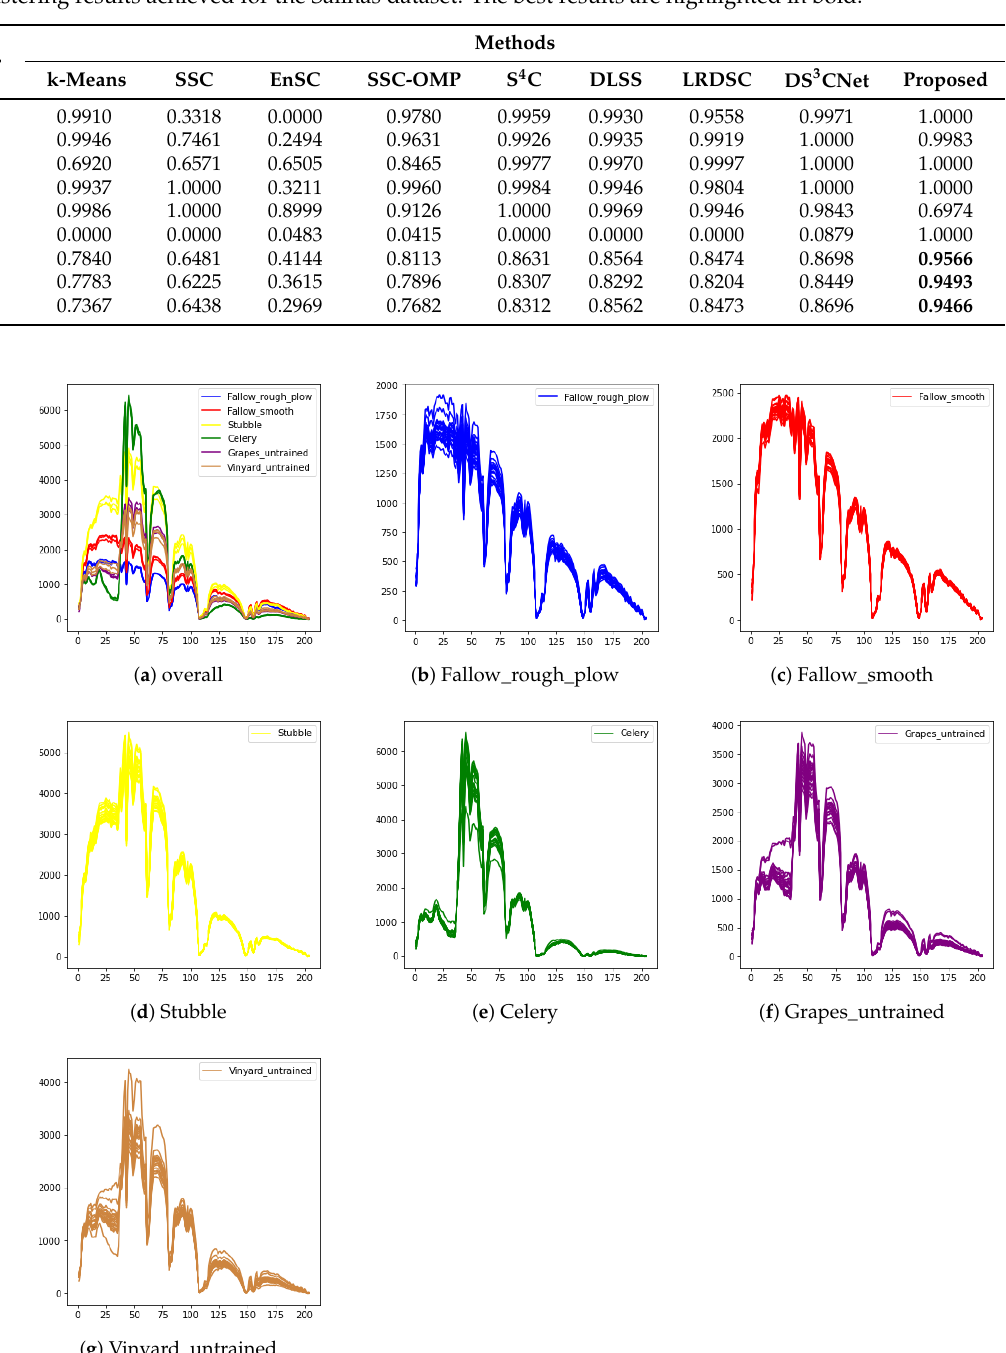
Table 6. The clustering results achieved for the Salinas dataset. The best results are highlighted in bold.